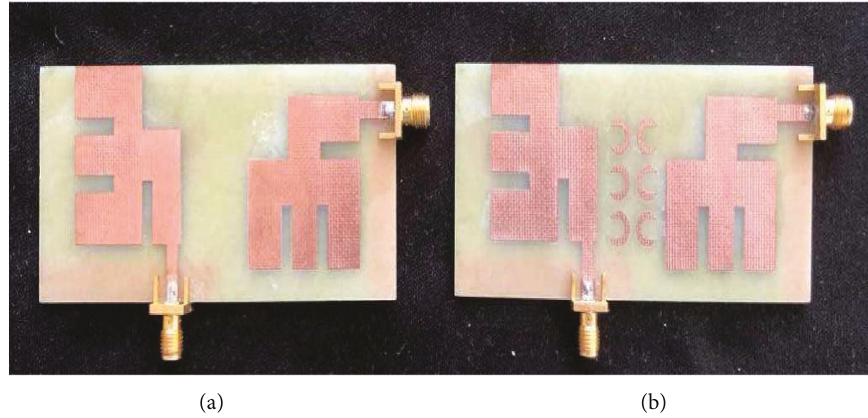
Figure 16: Fabricated antenna in orthogonal con fi guration (a) without and (b) with CSR structure.